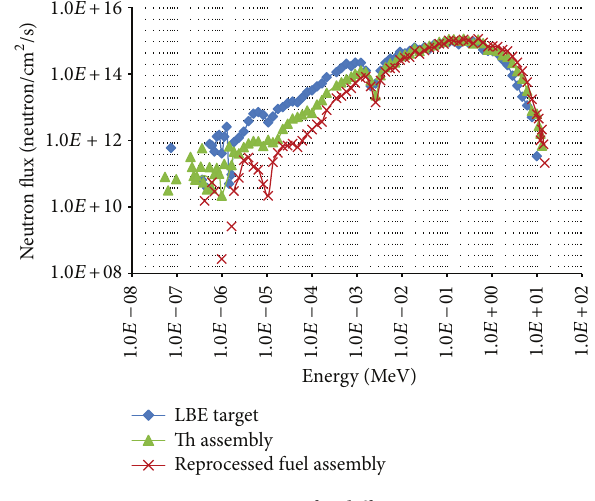
Figure 2: Neutron energy spectra for different regions in ADS core.